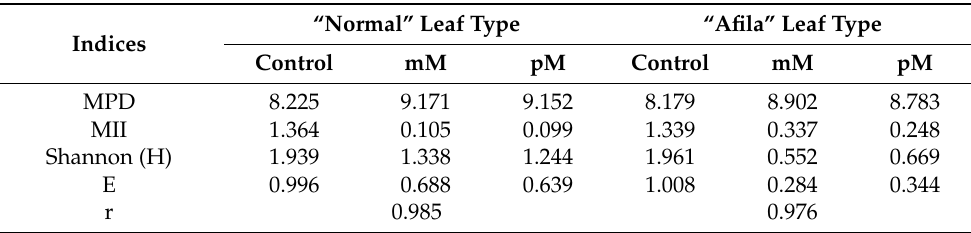
Table 2. Average population density in the microbial communities (CFU g − 1 a.d.s./log) and values of the calculated indices to assess the state of homeostasis, distribution evenness and richness in the rhizosphere microbiota of garden peas after inoculation with AM